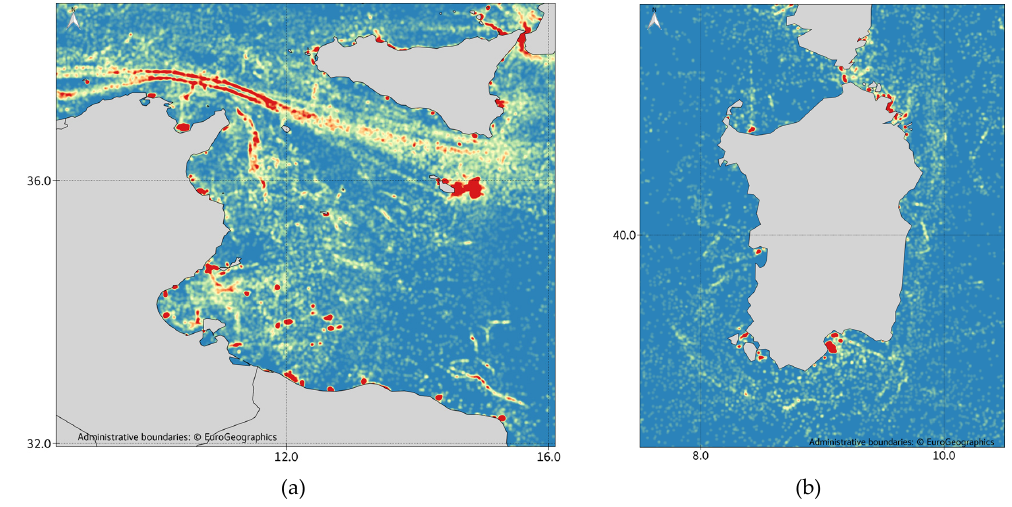
Figure 13. Close up sections: ( a ) South of Sicily; and ( b ) around Sardinia of the density map of non-recurrent ship detections (Figure 12).